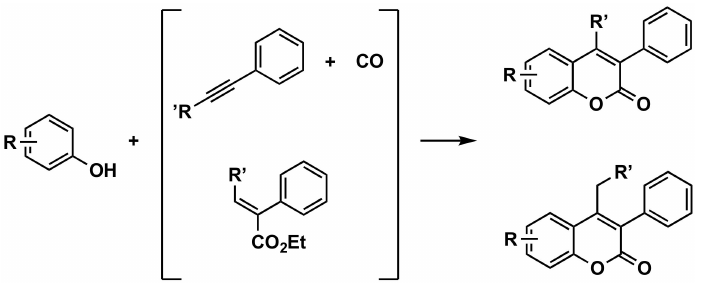
Figure 5. One of the synthetic routes to obtain 3-phenylcoumarins: construction of the coumarin from phenols.